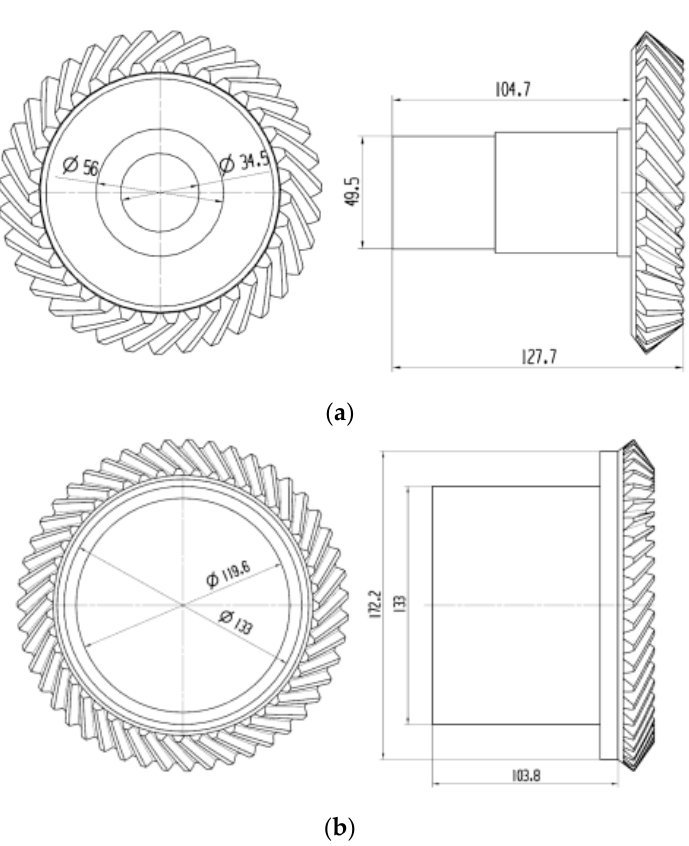
Figure 9. Two-dimensional model of gear mesh. ( a ) driven gear; ( b ) driving gear.